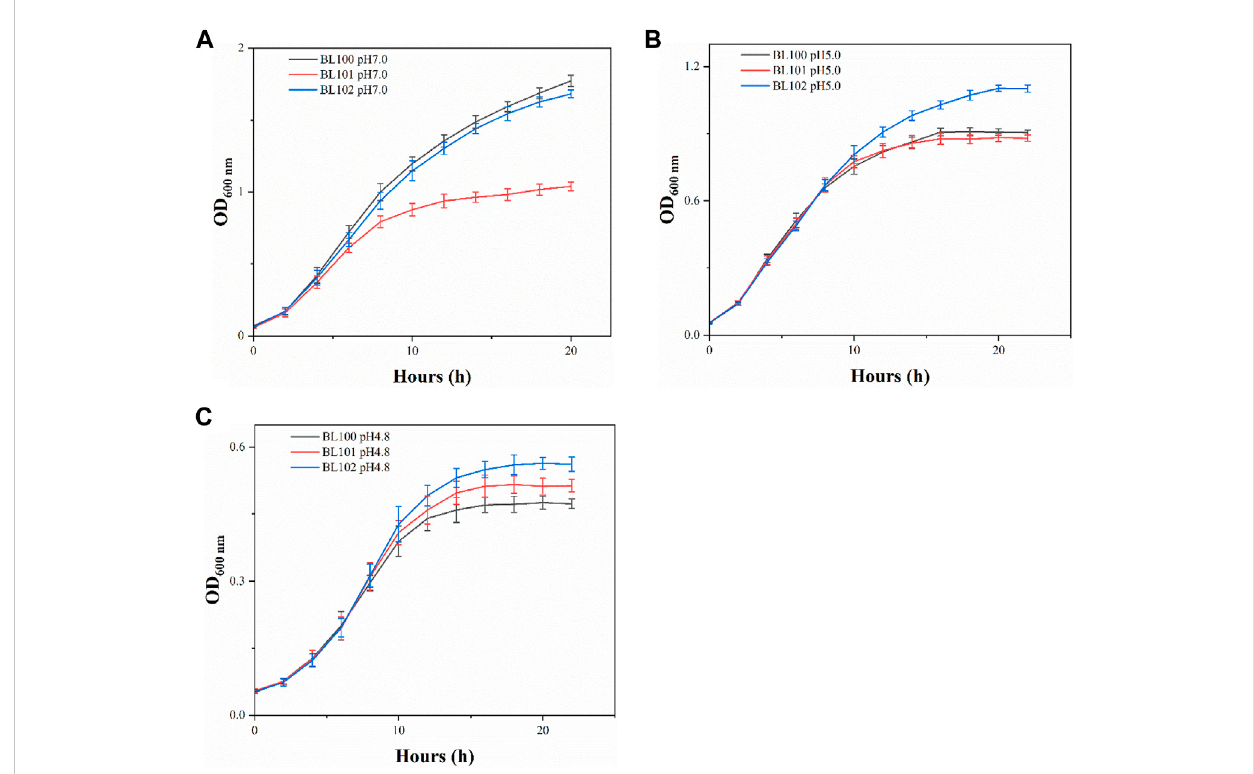
FIGURE 1 The overexpression of cfa 2 from A. caldus improved the acid resistance of E. coli . (A – C) The growth curves of strains BL100-102 cultivated in E minimum medium with pH 7.0, pH 5.0 and pH 4.8, respectively. The error bars represented means ± standard deviations (SD).